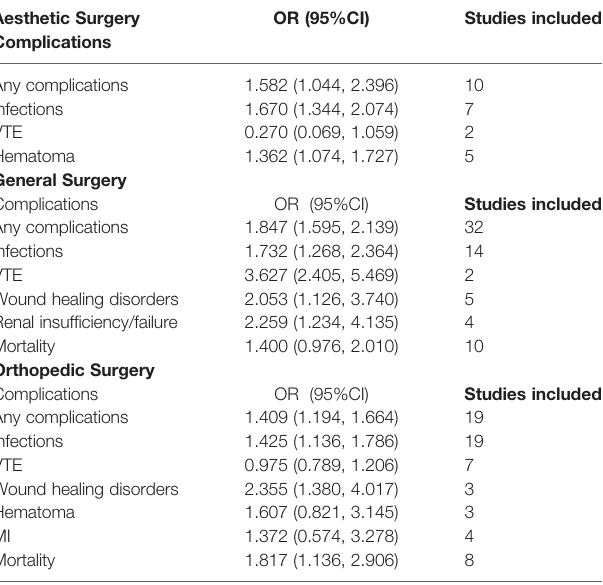
TABLE 3 | Outcomes of subgroup